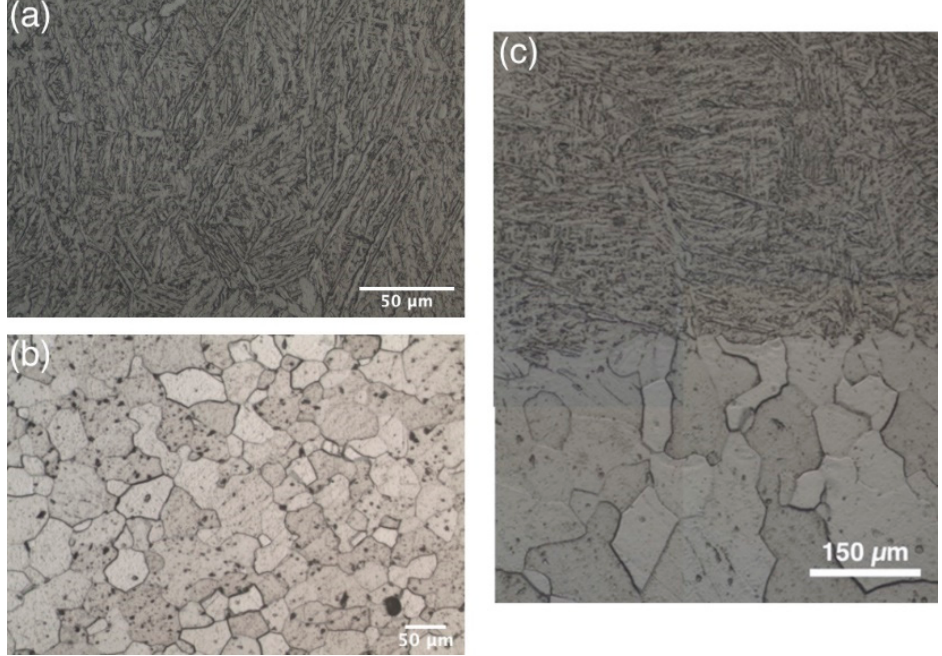
Figure 5. Microstructures of Ti/Ti64 sample after heat treatment: ( a ) Ti64 zone, ( b ) Ti zone, ( c ) the transition zone.